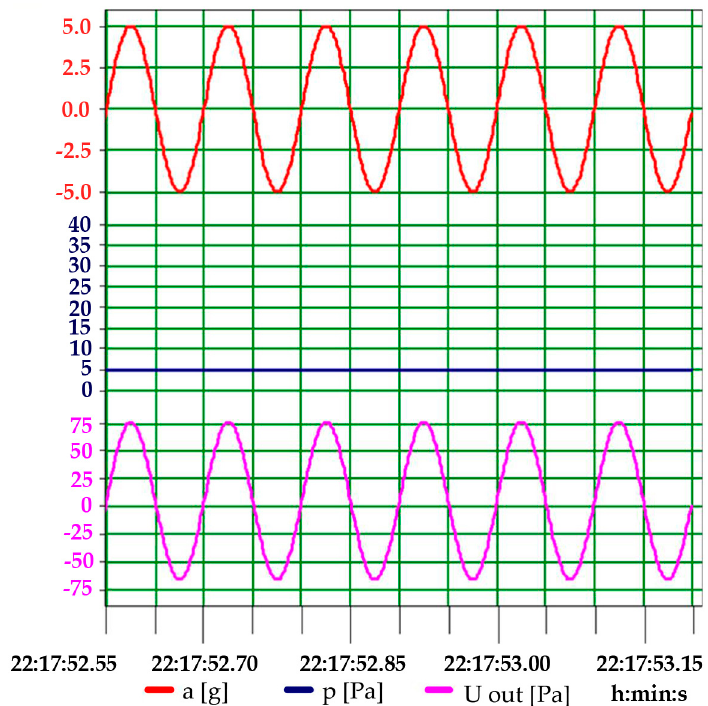
Figure 10. Waveforms of the experimental values of acceleration (a), pressure (p), and output signal (U out ) for dynamic acceleration with vibrations and with an amplitude of 5 g, frequency of f = 10 Hz, and pressure excitation of p = 5 Pa.